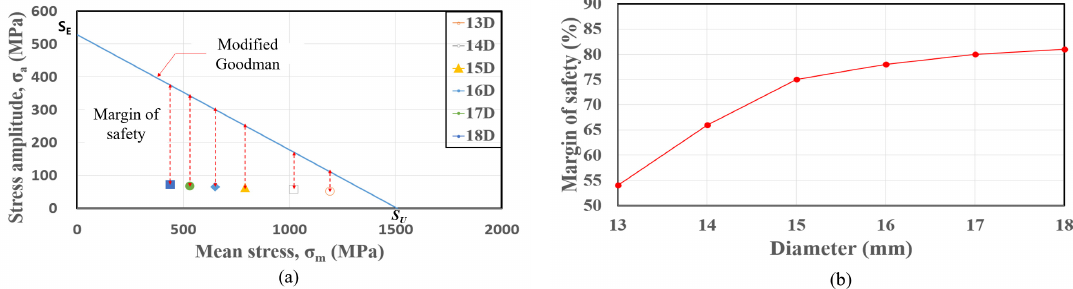
Figure 17. Comparison of the fatigue performance when varying the spring diameter: ( a ) fracture criteria; ( b ) margin of safety (%).